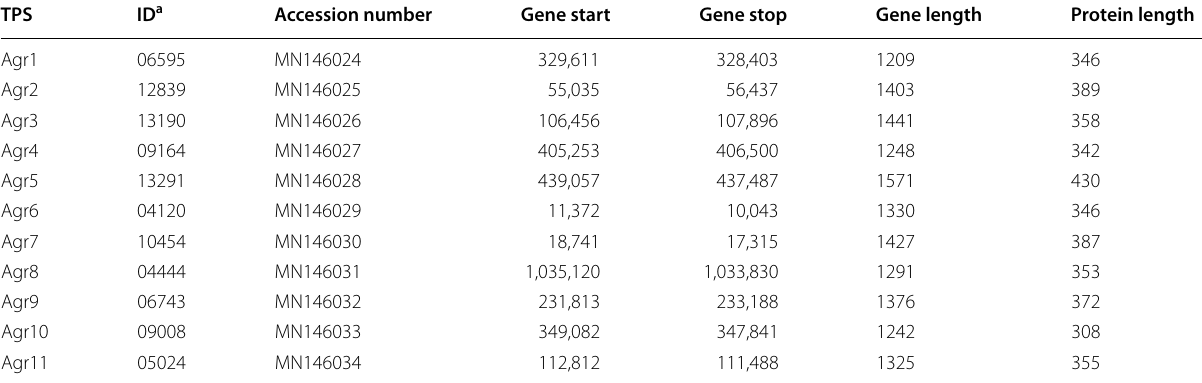
Table 1 Gene coding for TPS in A. aegerita